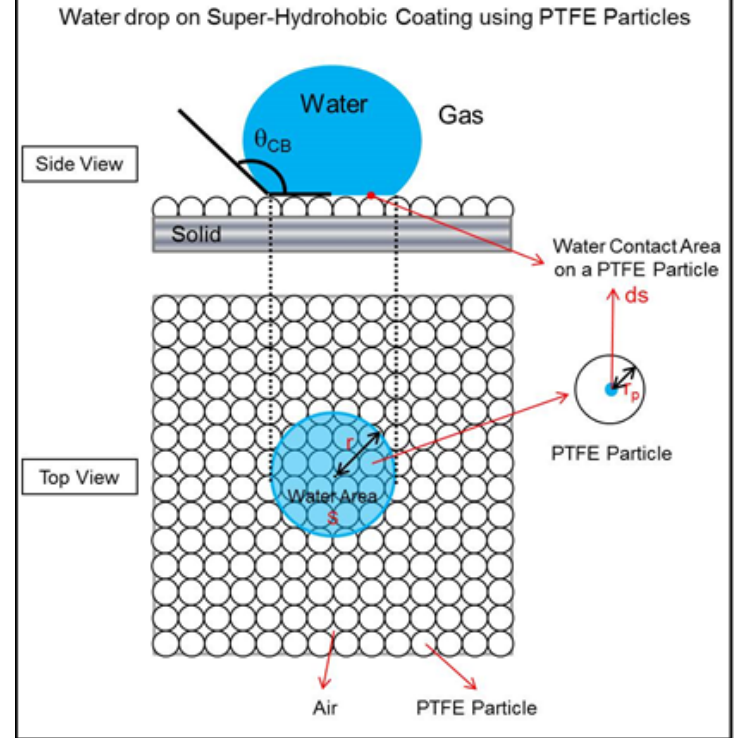
Figure 2. Schematic description of wetted area related to the PTFE particle size.